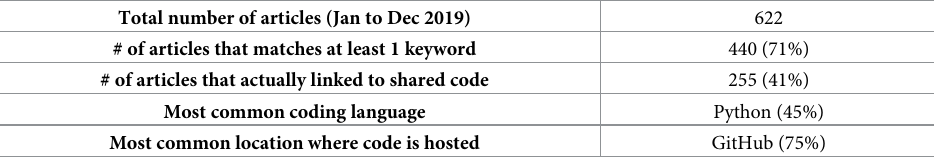
Table 1. Broad overview of